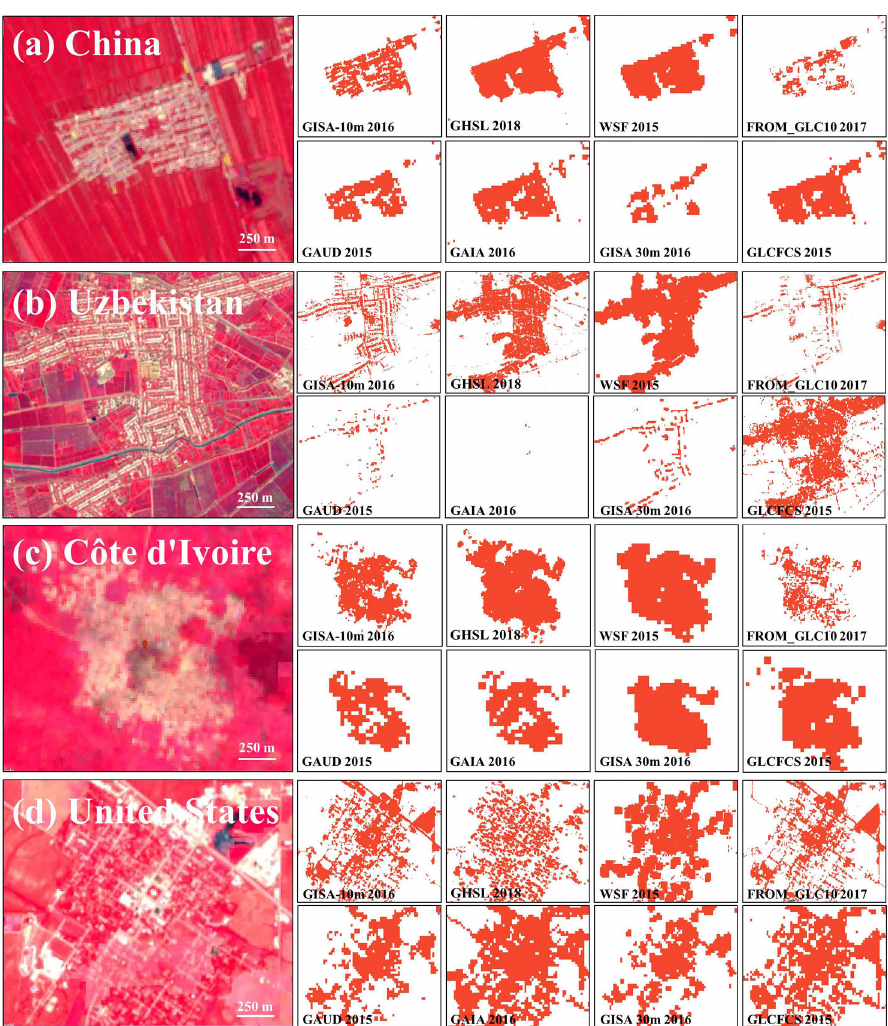
Figure 11. Comparison between GISA-10m and the seven datasets over rural regions in (a) China (126.348044 ◦ E, 45.269079 ◦ N); (b) Uzbekistan (60.573313 ◦ E, 41.461425 ◦ N); (c) Côte d’Ivoire (5.853317 ◦ W, 6.820244 ◦ N); and (d) the US (90.210747 ◦ W, 39.950221 ◦ N). The illustration is of Sentinel-2 images with a false-color combination (R: NIR, G: red, B: green) to enhance the